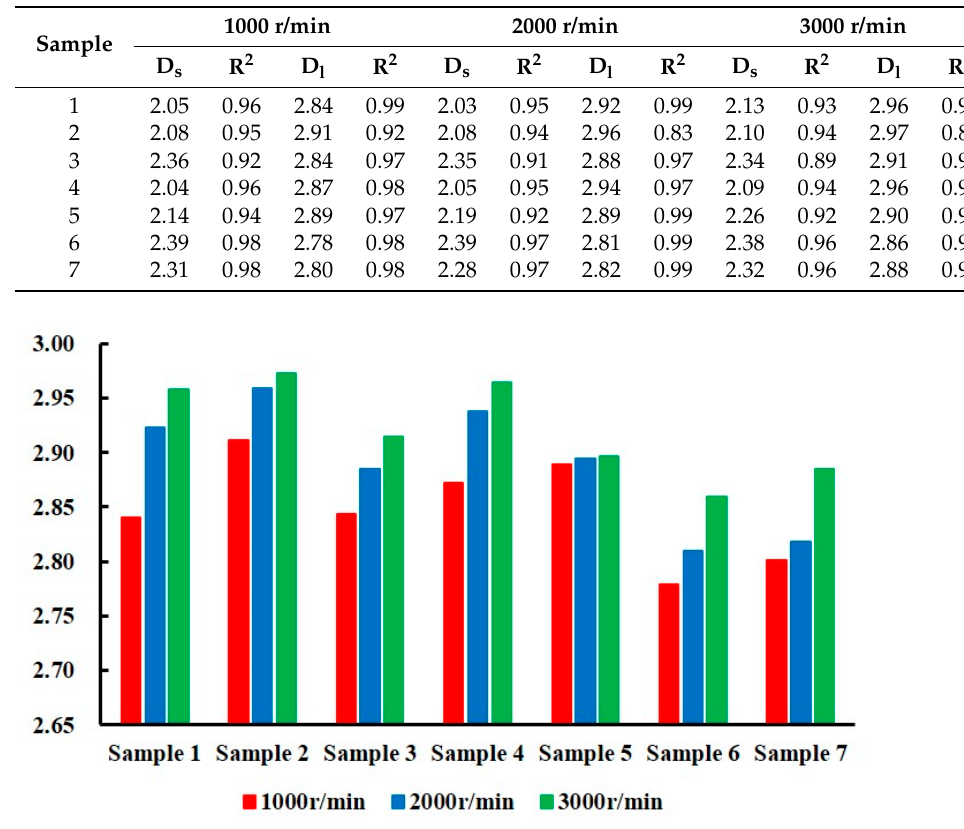
Figure 10. Trends of D l in different centrifugal speed.